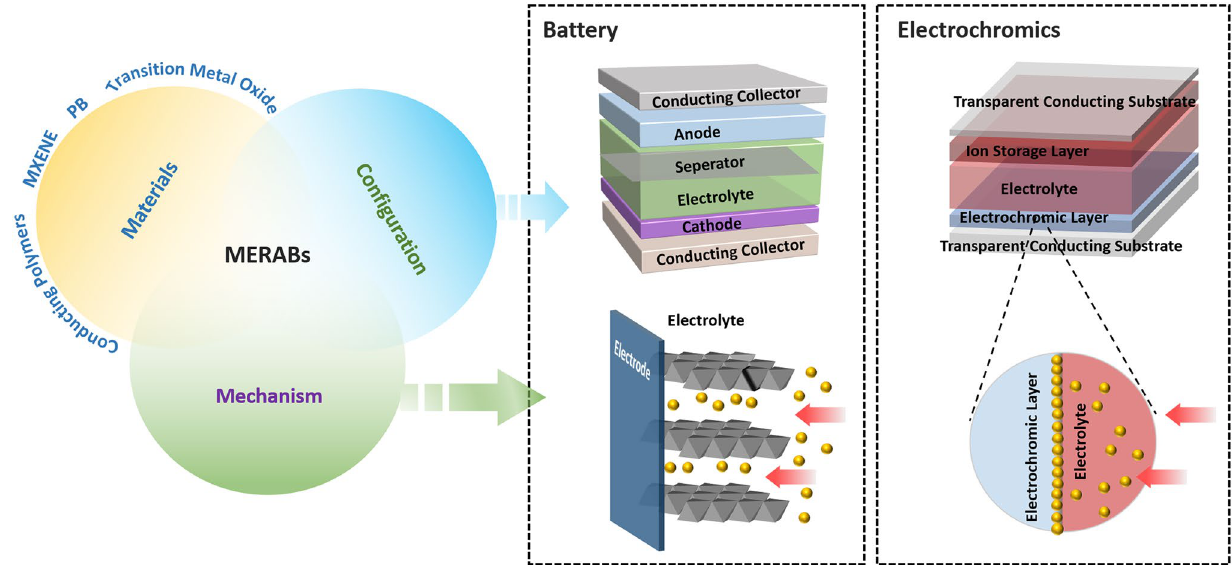
Fig. 3 Comparison between the electrochromic device and battery. Schematic illustration of the similarity in electrochromic device and battery in materials, mechanism and